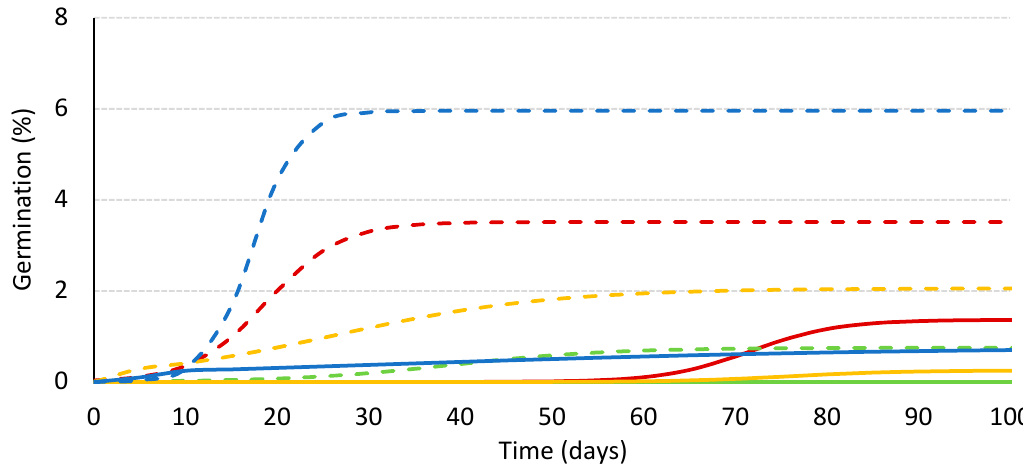
Figure 1. A logistic model fitted to the cumulative germination curves of caper seeds. Mean values for the combination of seed age (0.5-, 2-, 4-, and 5-year old seeds in red, green, yellow, and blue, respectively) and substrate saturation solution (water in continuous lines and gibberellic acid (GA) solution in dashed lines). Table 2. Effects of the seed lot age (years) and the saturation solution on the germination parameters: Final germination percentage ( A , %), time (d) required to reach 50% of final germination ( Gt 5 0 ), and average germination rate ( k/2 ; d − 1 ). Mean values.